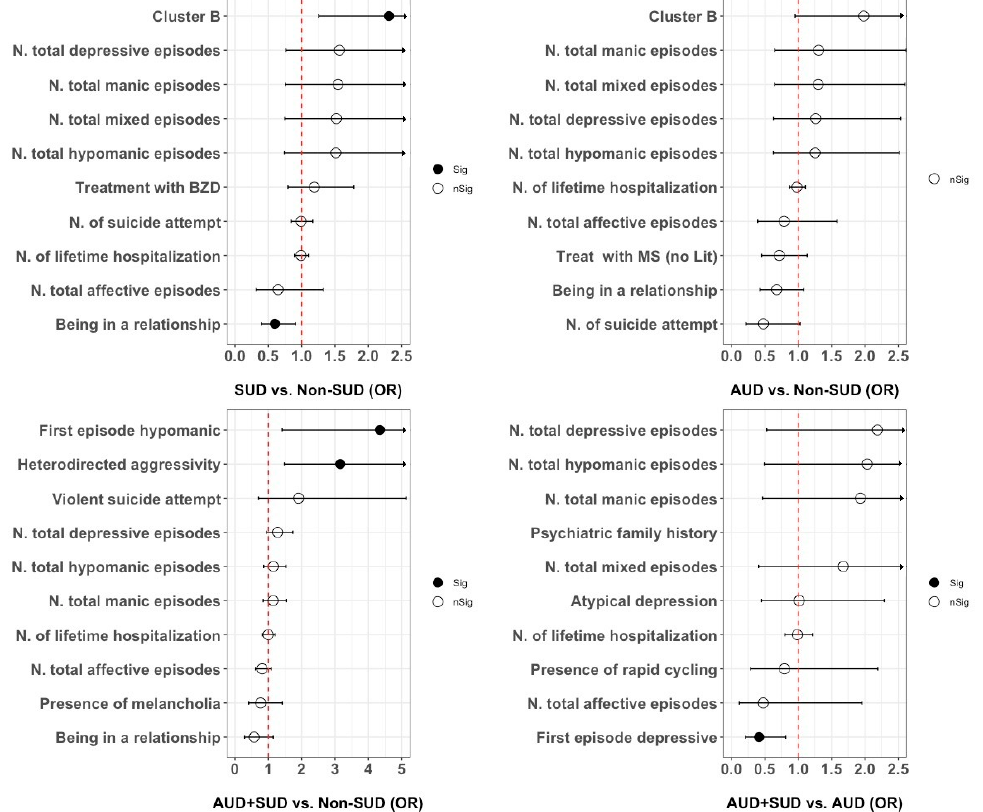
Figure 1. Logistic regression plots of odds ratio (OR) and 95% confidence intervals (CI). Independent variables were selected among the top ten features derived from the random forest (RF) models. The four models predicted (from left to right): any substance use disorder (SUD) in the total sample, alcohol use disorder (AUD) in the total sample, AUD co-occurrence with at least another SUD in the total sample, and AUD co-occurrence with at least another SUD among BD patients with AUD.